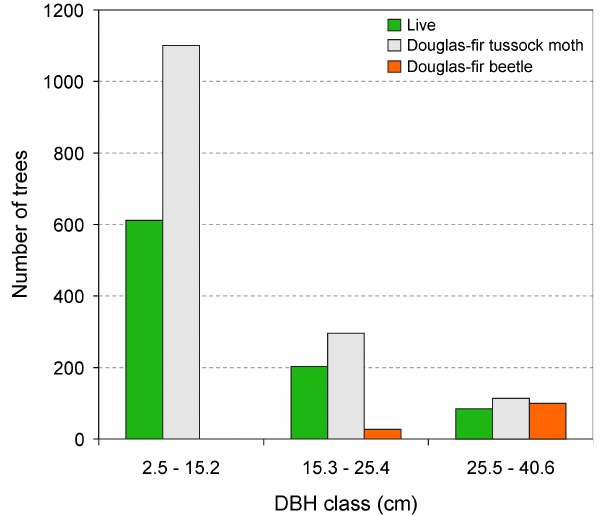
Figure 3. Total number (therefore no standard error) of live, Douglas-fir tussock moth-killed, and Douglas-fir beetle-killed trees across all plots and across diameter at breast height (dbh) classes. No Douglas-fir beetle-killed trees in the smallest diameter class. Pike-San Isabel National Forest, Colorado, USA, 1996–1997.